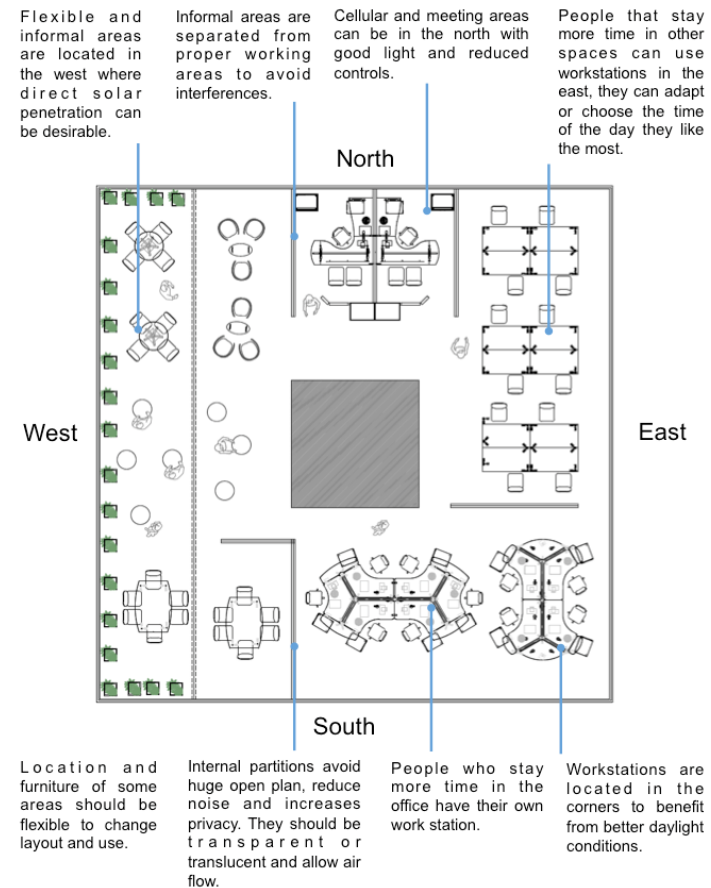
Figure 22. Diagrammatic space planning and layout proposal for the occupation of a typical working floor plan in an office building in Bogotá.